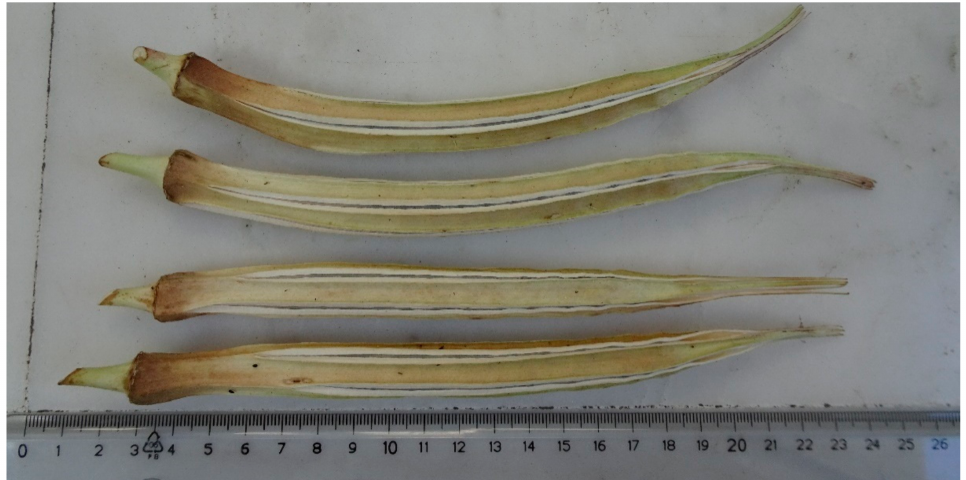
Figure 4. Platanos local okra landrace pod samples (ruler in